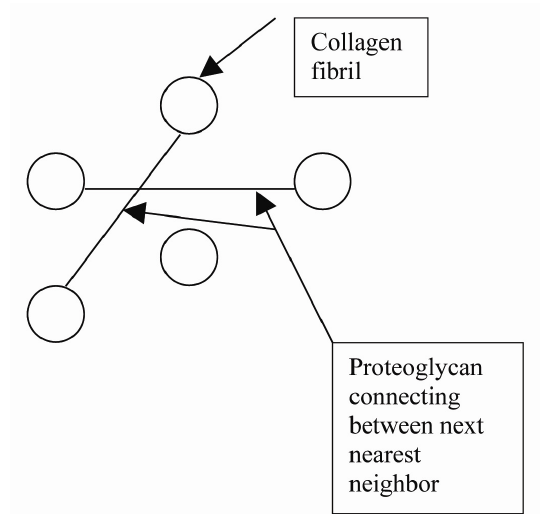
Figure 1a Schematic of collagen fibrils with proteoglycan cross-links between fibrils (figures adapted from reference 13).